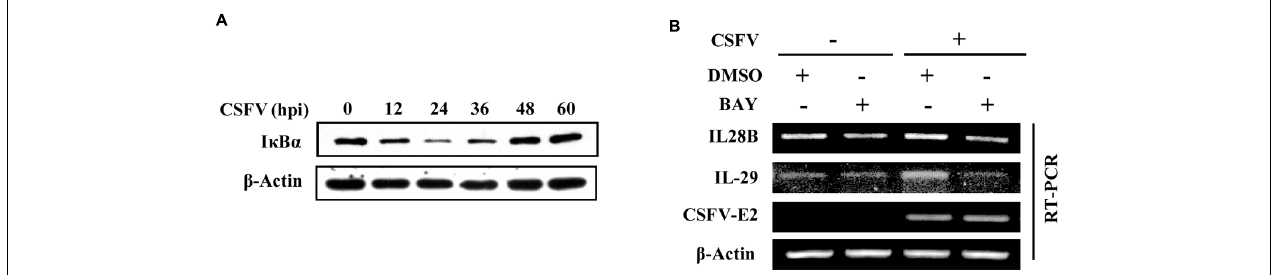
FIGURE 3 | NF- κ B is involved in regulation of type III IFNs expression in PK-15 cells infected with CSFV. (A) PK-15 cells were infected with CSFV for indicated time, followed by Western blotting with indicated antibodies. (B) PK-15 cells were pre-treated with either BAY11- 7082 (NF- κ B inhibitor) or DMSO (mock treatment control) for 3 h, and then infected with or without CSFV for 36 h. The cells were harvested and followed by RT-PCR analysis of IL-28B and IL-29 levels. Shown are representative of three independent experiments with similar results.